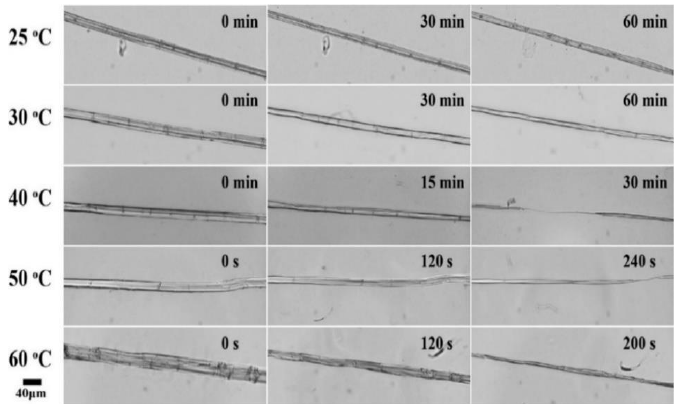
Figure 3. Optical microscope images of a flax fiber radially dissolving in ionic liquid (IL) at various temperatures.